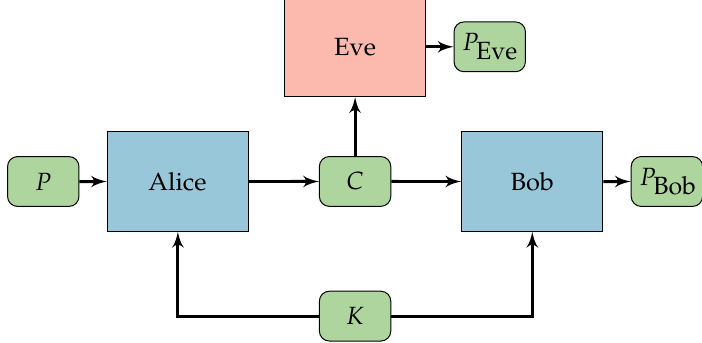
Figure 1. Alice, Bob, and Eve, with a symmetric